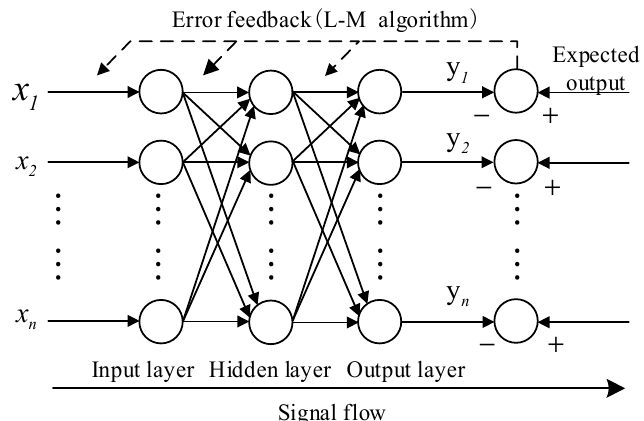
Figure 8. Neural network structure model.